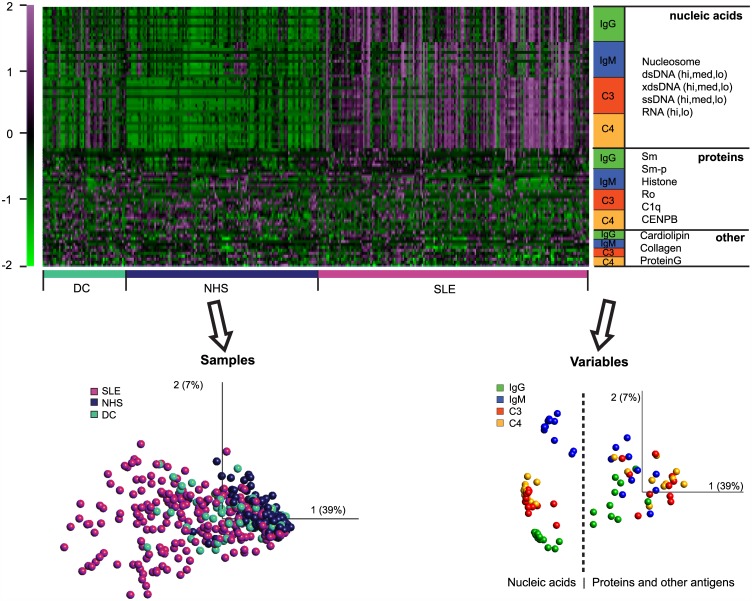
Heatmap and principal component analysis of the functional antibody profiling data.Samples are ordered as study groups. Variables are grouped by the molecular composition and the nature of the detected serum immunoglobulin or complement protein, the order of the particular antigens is shown and applies for each detected protein. PCA plot of samples shows the distribution of samples in the space of the first two components. The variable plot shows the contribution of the variables to the generation of this space, where distance and orientation from the zero origin define a particular interaction’s load in the first two principal components. Percentages in parenthesis indicate contribution of the indicated principal component to overall variability in the dataset. xdsDNA, ultrasound-fragmented dsDNA; CENPB, centromere protein B; Sm-p, peptide of Smith antigen D polypeptide